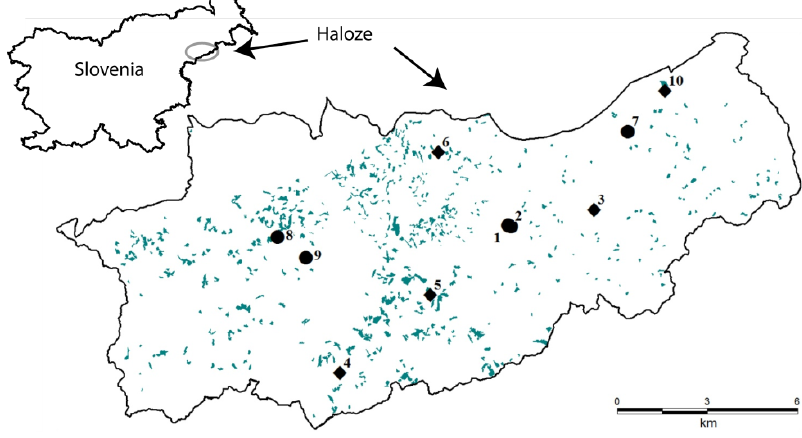
Figure 1. Location of the Haloze region in Slovenia and tending research plots within the study area; the plots are marked with numbers from 1 to 10 (circle—thicket, diamond—pole stand); dark cyan patches mark new forests on abandoned agricultural